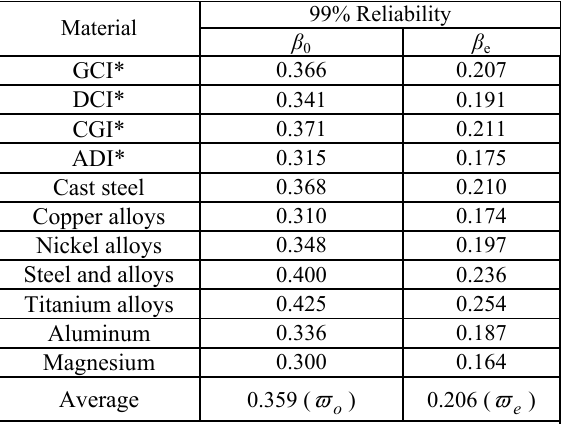
Table 4: Nominal Bending Strength Estimate Comparison for Gray Cast Iron Materials Minimum Tensile Strength